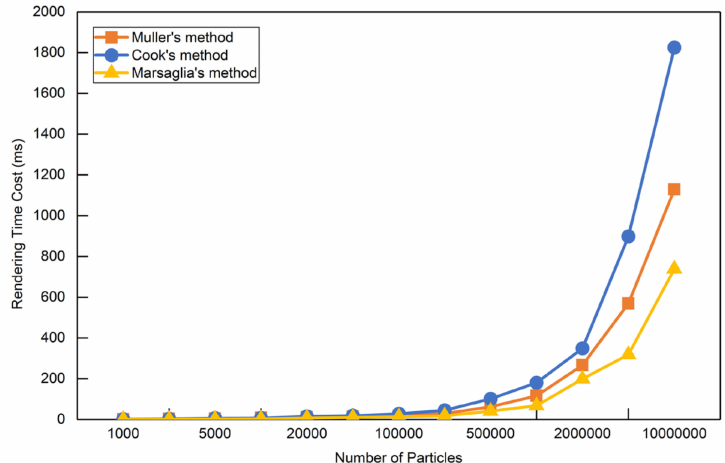
Figure 7. Points generation time of different methods.